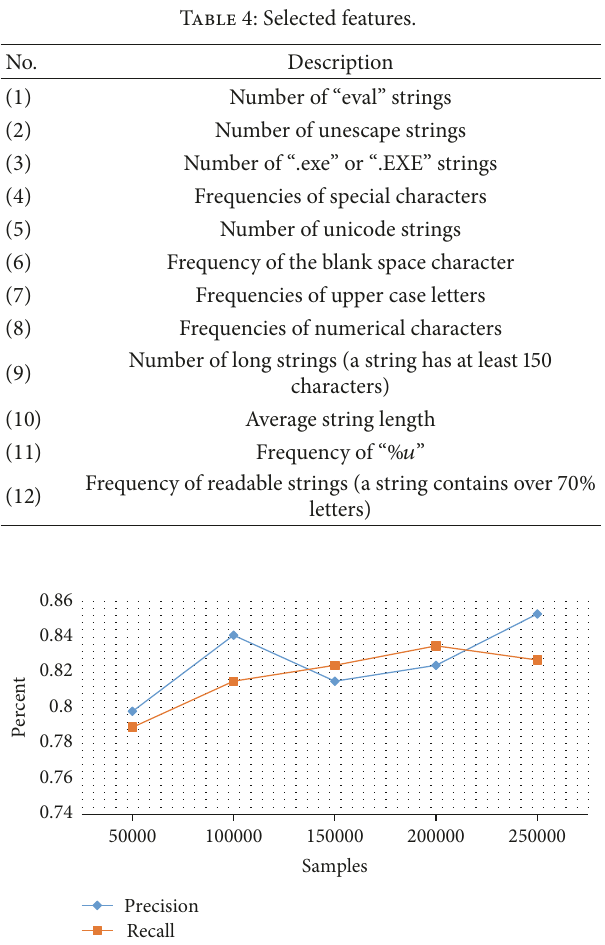
Figure 9: The precision and recall on malicious URL